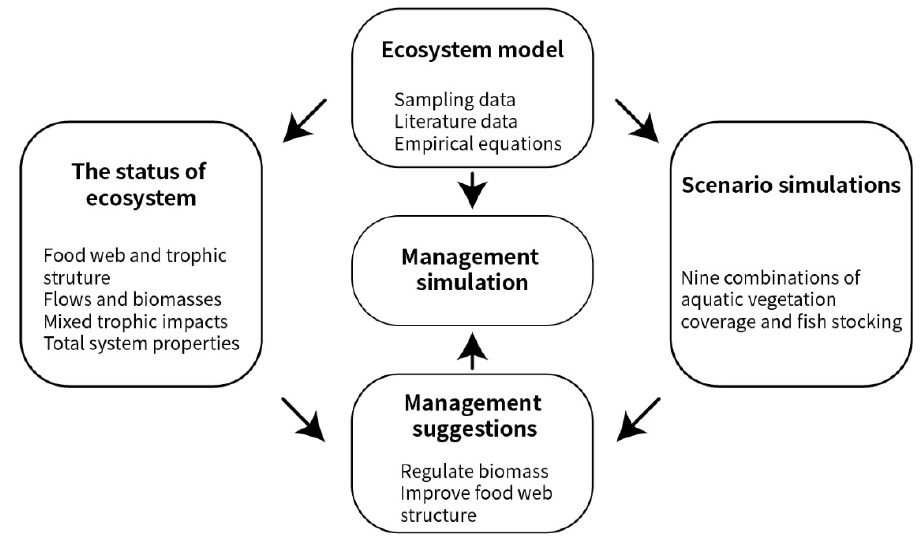
Figure 1. Analytical flowchart of this study.